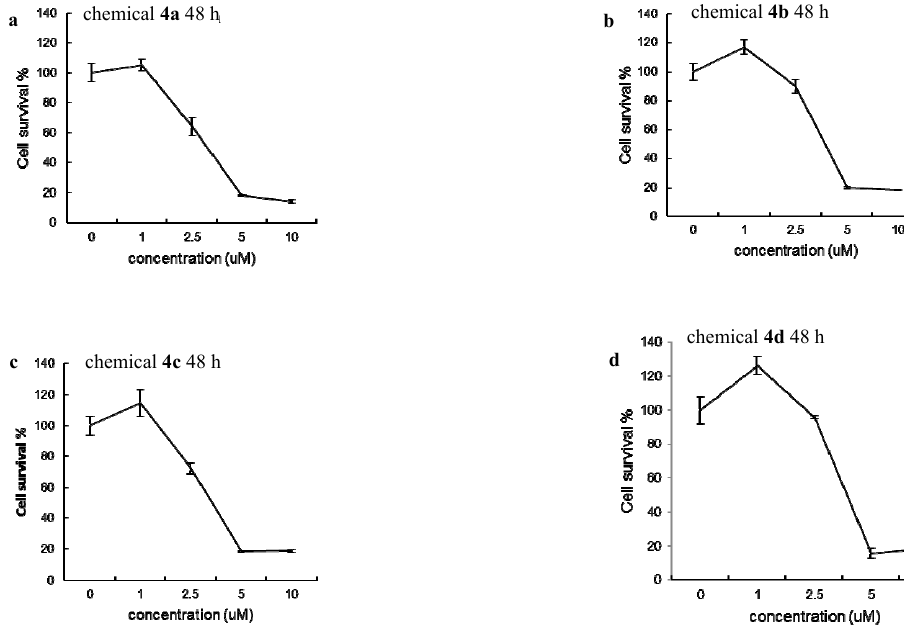
Figure 2. Synthesized chemicals inhibit PC-3 cell survival in a dose-dependent manner. PC-3 cells were treated for 48 h with chemicals at different concentrations and analyzed via WST-1 cell growth assay: ( a ) chemical 4a ; ( b ) chemical 4b ; ( c ) chemical 4c ; ( d ) chemical 4d . Table 1. The IC 50 of values of nickel complex in LNCaP cells.